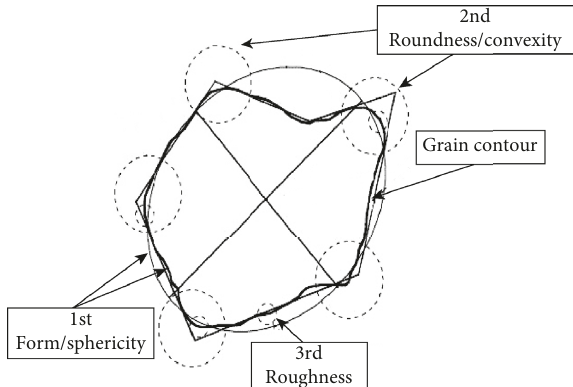
Figure 5: A grain contour (heavy solid line) with its three orders of component elements of form/sphericity, roundness, and surface roughness